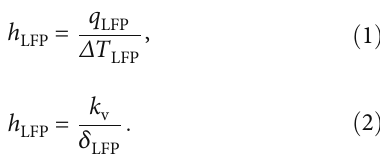
Figure 11: Experimental p